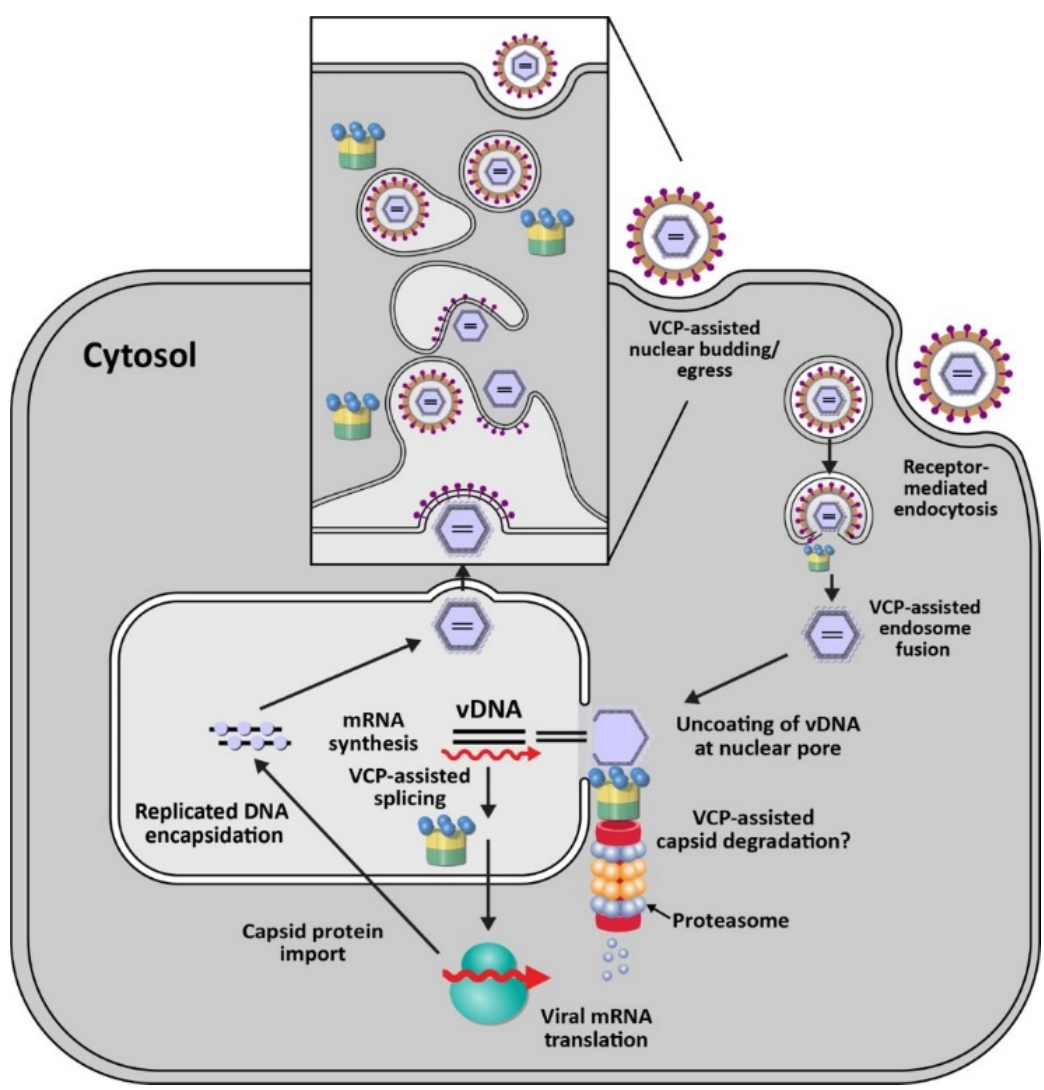
Figure 3. Role of VCP/p97 in the replication cycle of DNA-containing viruses. This figure is based on information derived from herpesviruses, particularly HCMV. VCP is depicted in the “up” conformation as shown in Figure 1. The DNA genome is depicted as two horizontal black lines, whereas viral mRNAs are shown as red arrows. The purple spheres on viral DNA represent capsid proteins. The inset reveals an enlarged view of viral egress from budding at the nuclear membrane, vesicle trafficking, and fusion of vesicles containing virus at the cell surface. Involvement of VCP in viral mRNA splicing and virion egress has been confirmed, but a role for p97 in uncoating is speculative.